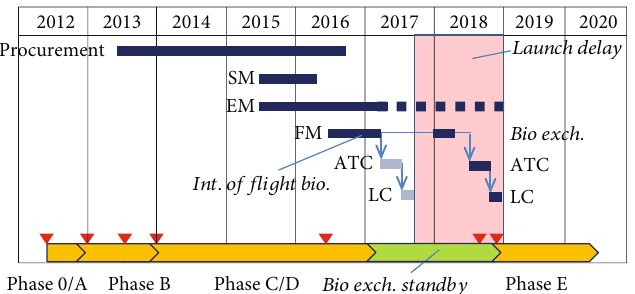
Figure 4: AIV schedule for